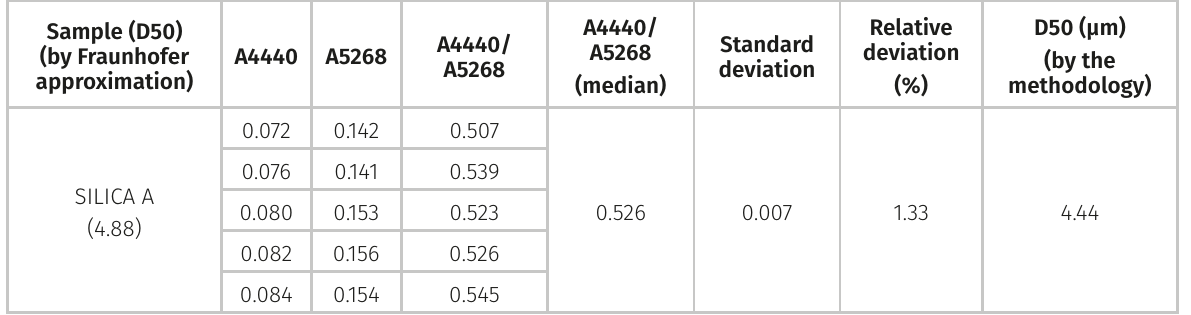
Table VII. Data related to NIRA methodology applied to the silica test sample. Sample (D50) (by Fraunhofer approximation)